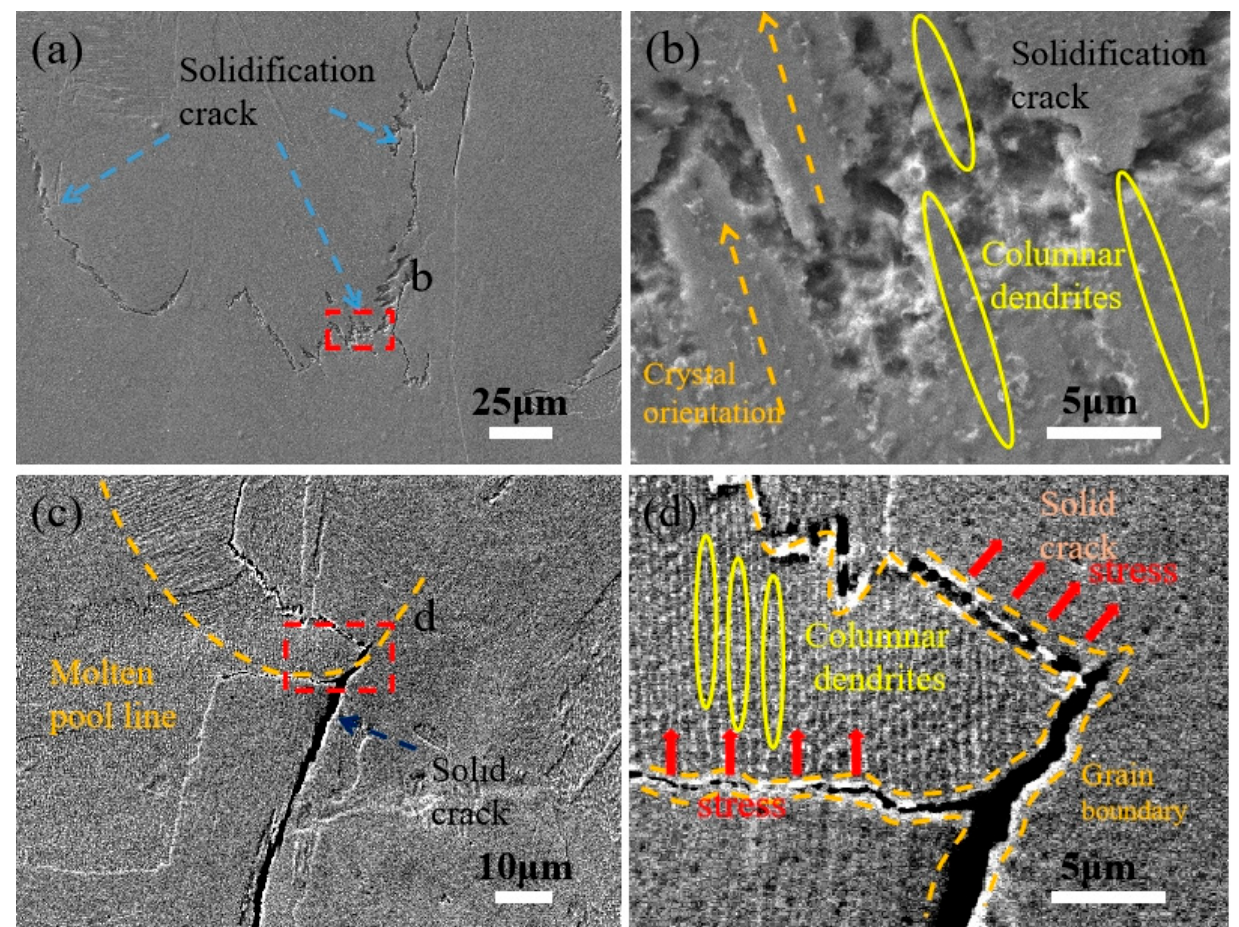
Figure 11. Crack morphology at high power, low scanning speed, and 90° interlaminar angle. ( a ) Solidification crack; ( b ) Local amplification of the area inside the dotted box in ( a ); ( c ) Solid crack; ( d ) Local amplification of ( c ).